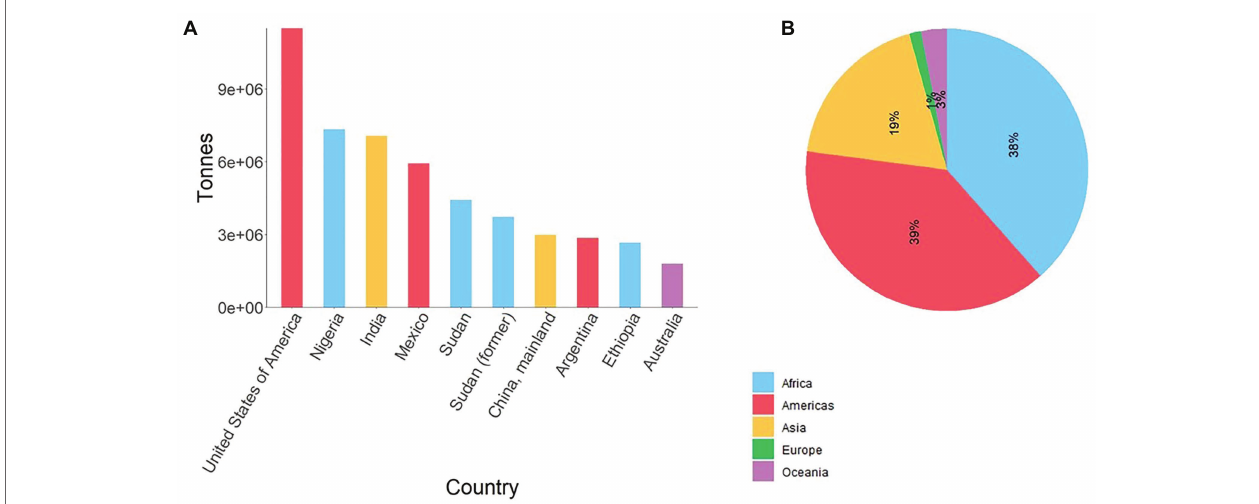
FIGURE 1 | (A) Average production of sorghum in top 10 sorghum producing countries from 1994 to 2018, and (B) corresponding production share by region. Data source (FAOSTAT, 2020). Sudan (former) reflects average sorghum production in Sudan and South Sudan up to 2011. For Sudan, the data represent average production from 2012 to